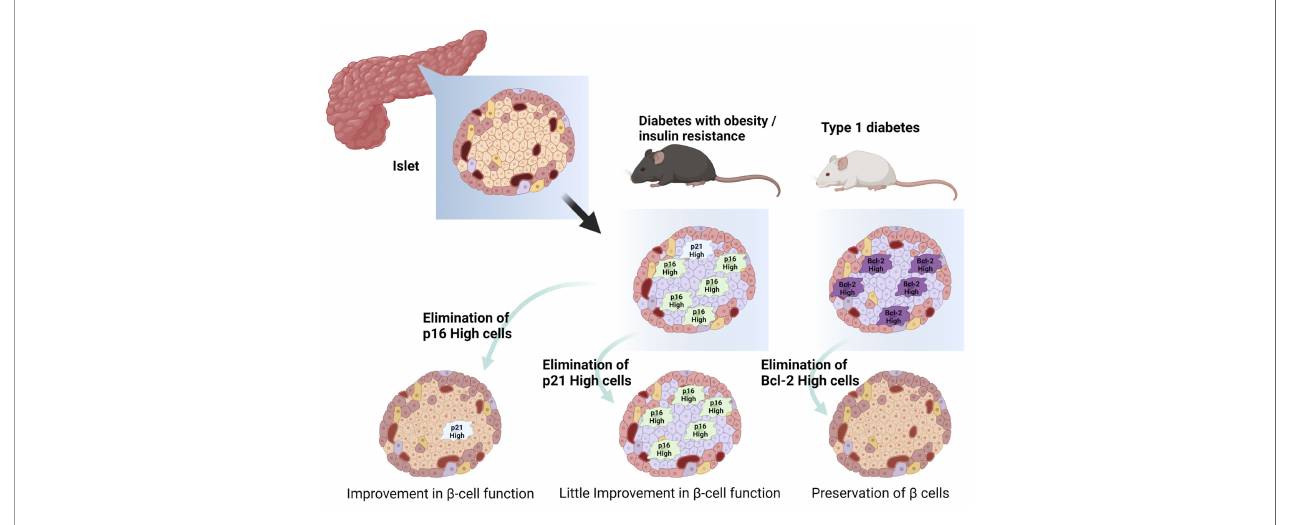
FIGURE 3 | Senolytic approach to pancreatic b -cell senescence. p16-high cells, p21-high cells, Bcl-2 high cells reside in pancreatic b cells with diabetes. Elimination of such senescent cells in islets restores b -cell function and/or prevents destruction of b cells. Created with